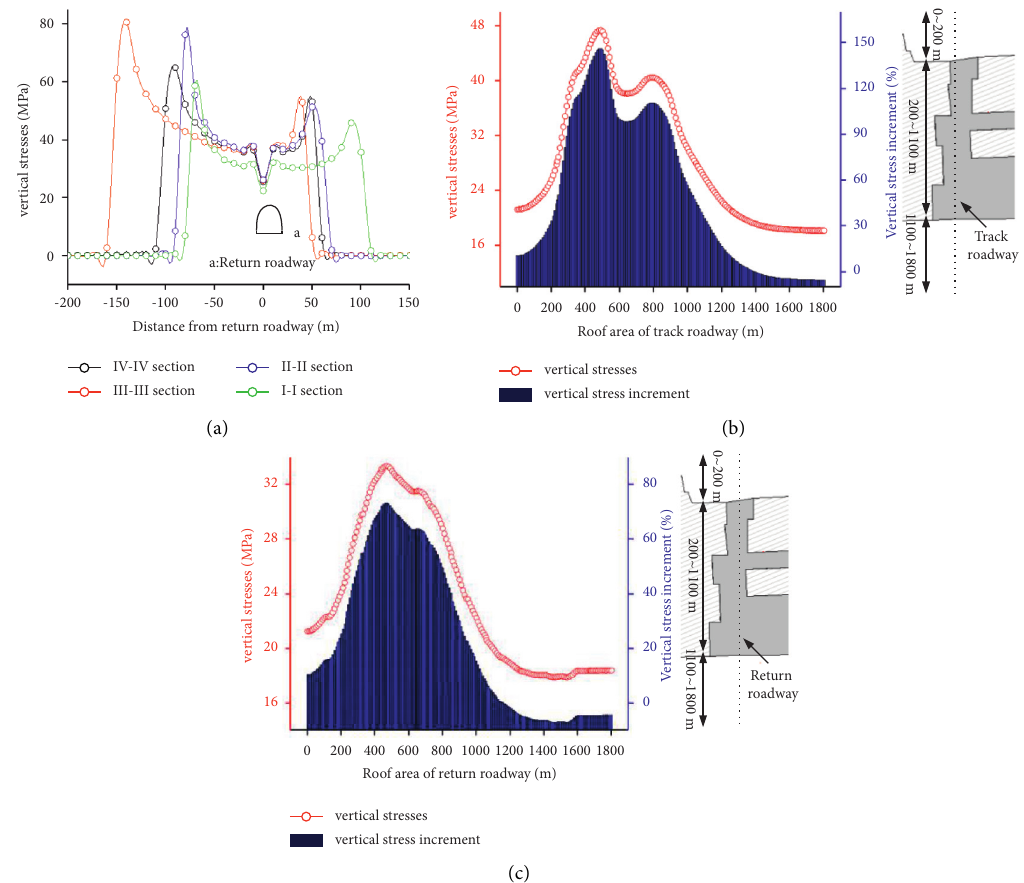
Figure 14: Stress change curve of coal and rock mass in isolated coal pillar area: (a) coal seam stress distribution in the coal pillar area (strike profile); (b) stress distribution in track roadway roof (tendency profile); (c) stress distribution in return roadway roof (tendency